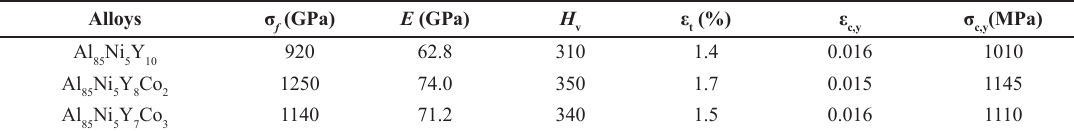
Y Ni Co ) Sc amorphous alloys 13 . 0.64 0.09 0.05 0.02 100–x x